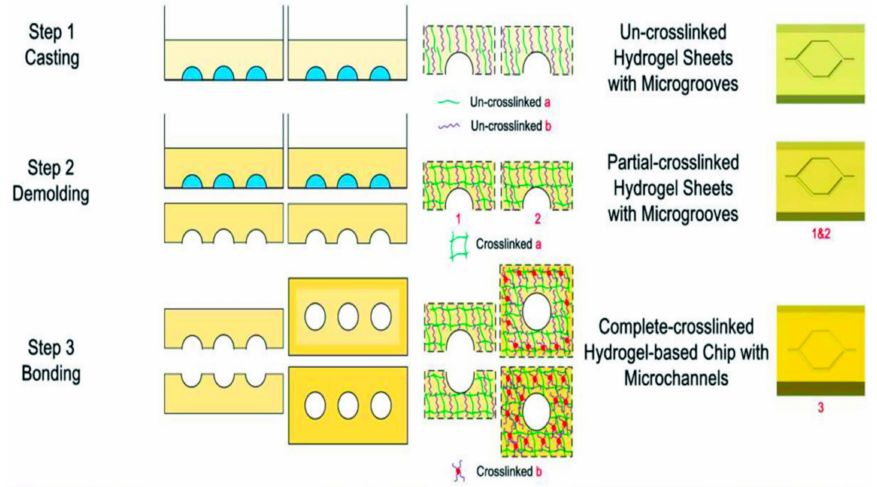
Figure 4. Schematic of the fabrication process for the hydrogel-based chip and its mechanism. Reproduced with permission [92].